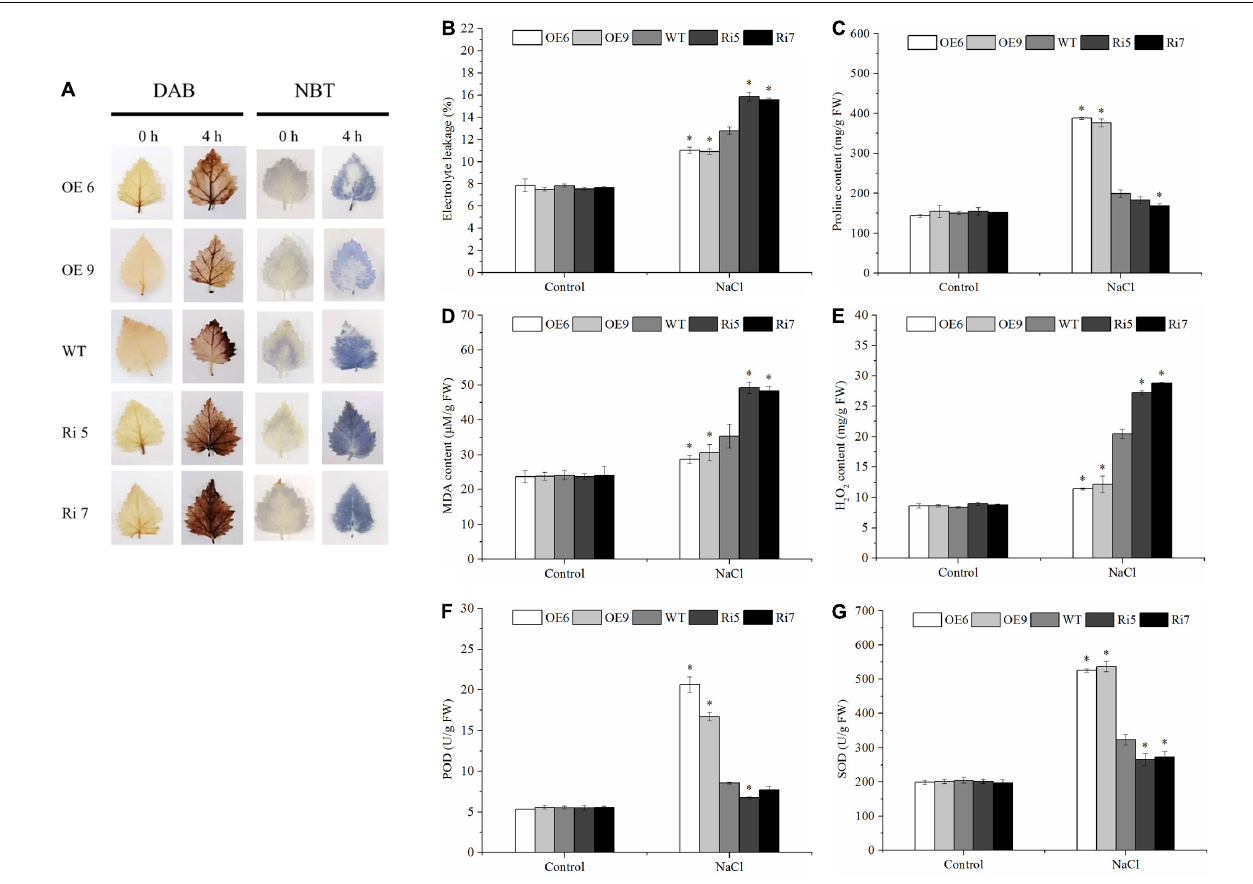
FIGURE 5 | Determination of malondialdehyde (MDA) content, electrolyte leakage, proline content, MDA content, ROS accumulation (Histochemical staining and H 2 O 2 content), superoxide dismutase (SOD) activity, peroxidase (POD) activity. Birch plantlets were treated with 200 mM NaCl for 0 h (control) and 6 h, and then their leaves were detached and stained with NBT (A) and DAB (B) to detect H 2 O 2 and O 2 − . (B) Electrolyte leakage, (C) proline content, (D) MDA content, (E) H 2 O